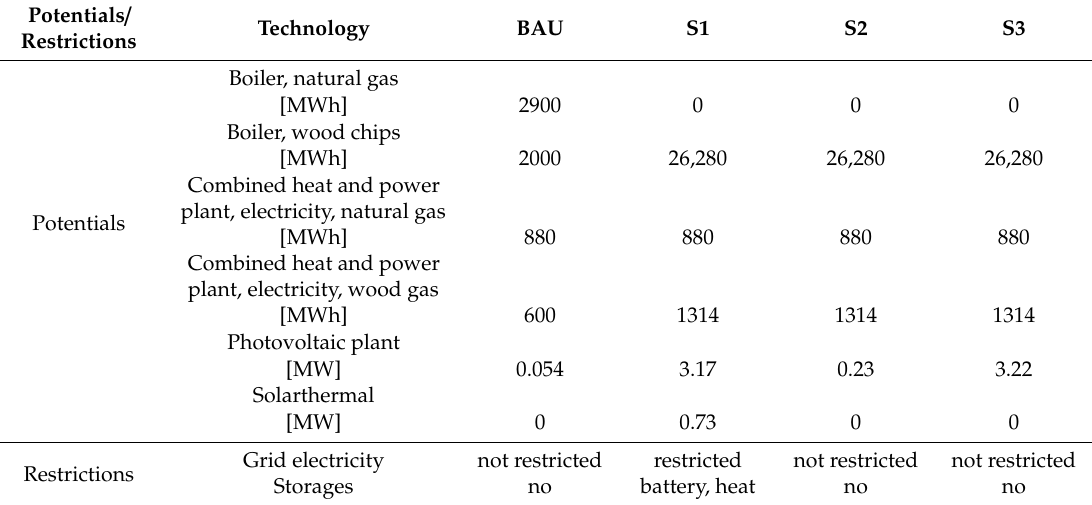
Figure 3. Sankey diagrams of the system configuration.